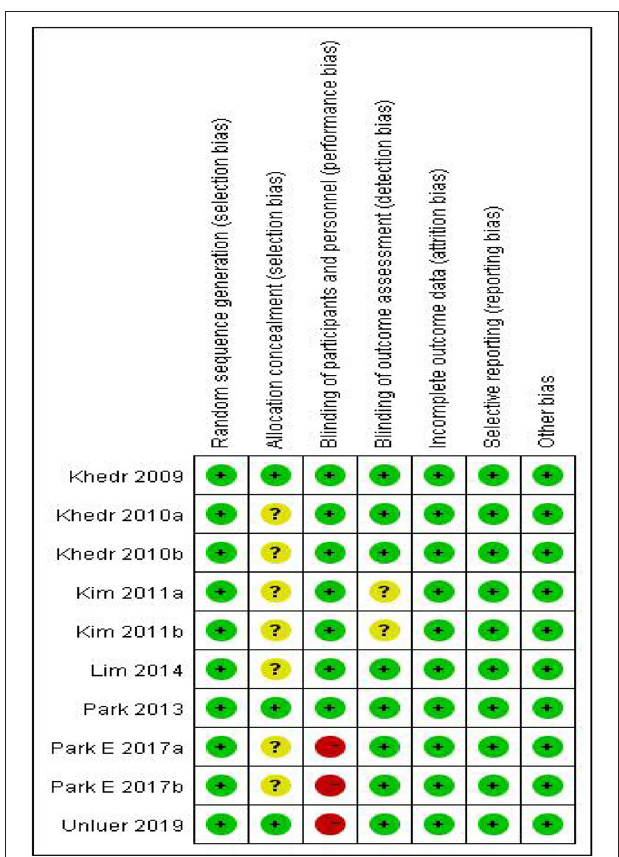
FIGURE 3 | Risk of bias